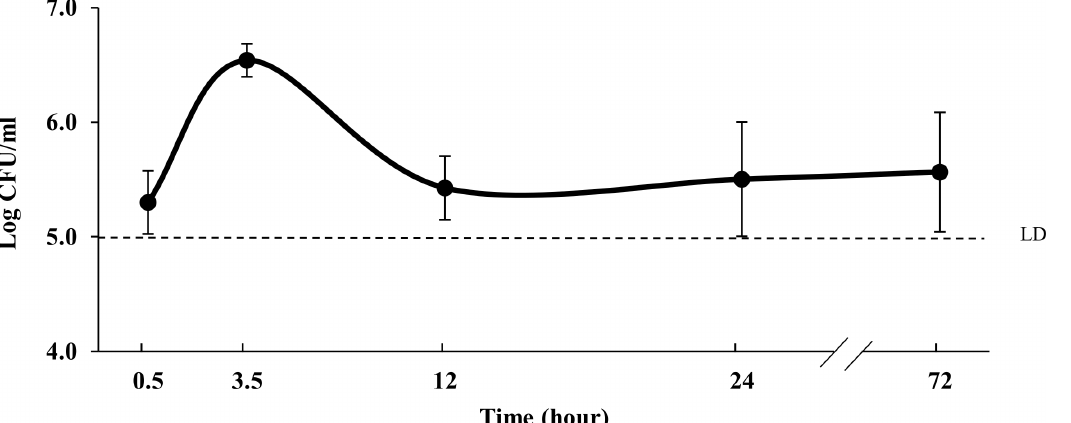
Fig 1. L . casei 32G detection in cecum digesta of mouse fed with 10 8 CFU/mouse at 0.5h, 3.5h, 12h, 24h, and 72h after last administration. (n:6/time point). LD, limit of detection.